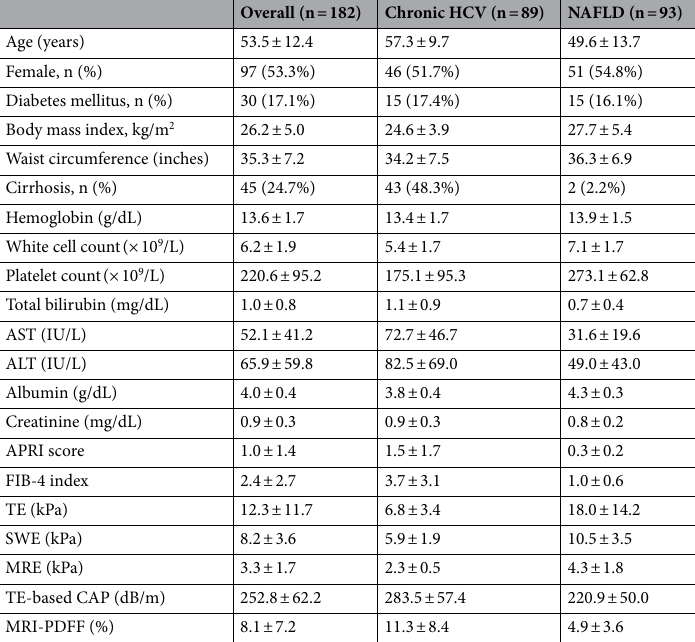
Table 1. Patient baseline characteristics. AST aspartate aminotransferase, ALT alanine aminotransferase, APRI AST to Platelet Ratio, CAP controlled attenuation parameter, FIB-4 Fibrosis-4, kPa kilopascal, MRE magnetic resonance elastography, MRI magnetic resonance imaging, PDFF proton density fat fraction, SWE shear wave elastography, TE transient